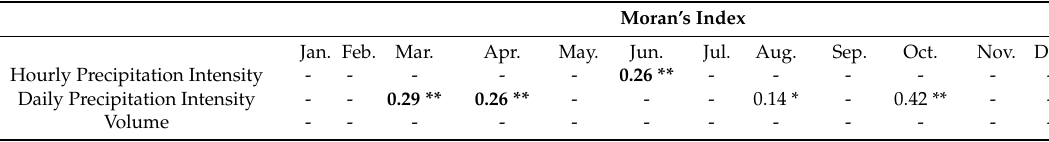
Table 1. Monthly Moran’s Index statistics. Items in bold represent months when field significance and increasing trends also occur.